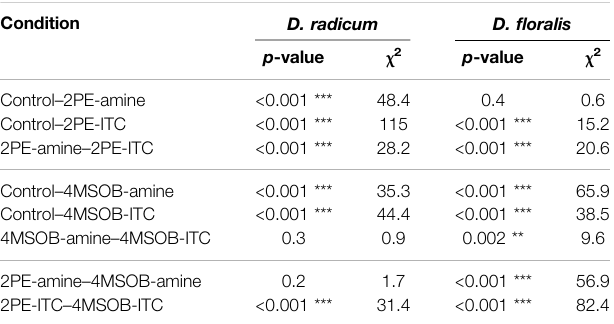
TABLE 4 | Log-rank-test of the survival in D. radicum and D. fl oralis feeding on a semiarti fi cial diet with 2-phenylethyl isothiocyanate (2PE-ITC), 2- phenylethylamine (2PE-amine), 4-(methylsul fi nyl)butyl isothiocyanate (4MSOB- ITC), 4-(methylsul fi nyl)butylamine (4MSOB-amine) or without ITCs or amines (control)